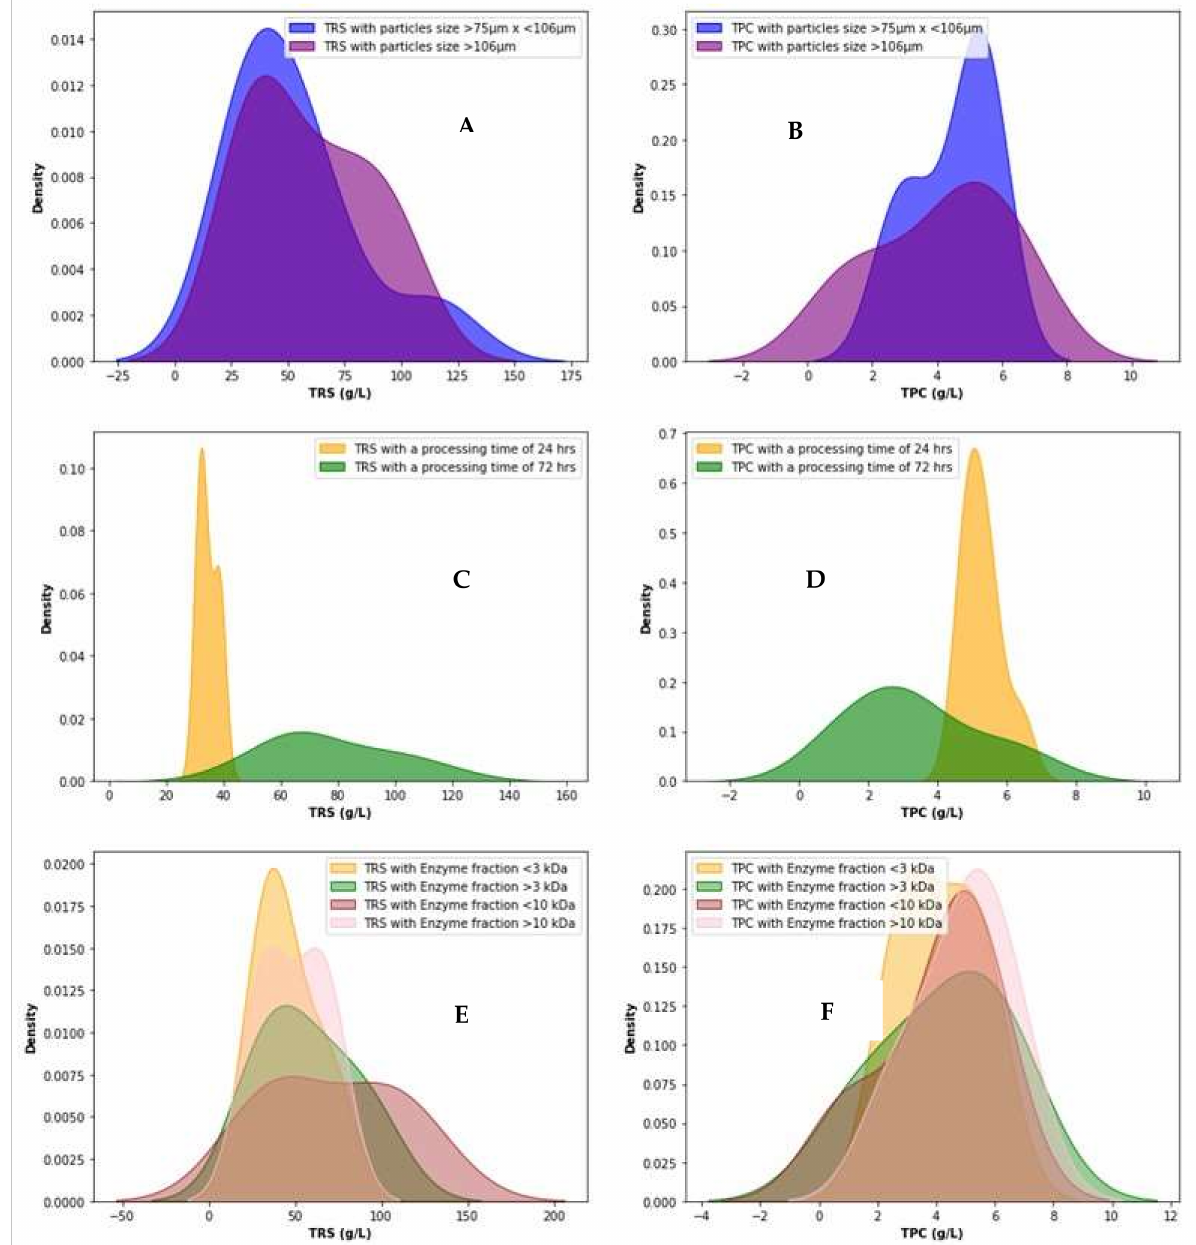
Figure 4. Probability density function of the TRSs and TPCs production with respect to various parametric conditions ( A – F